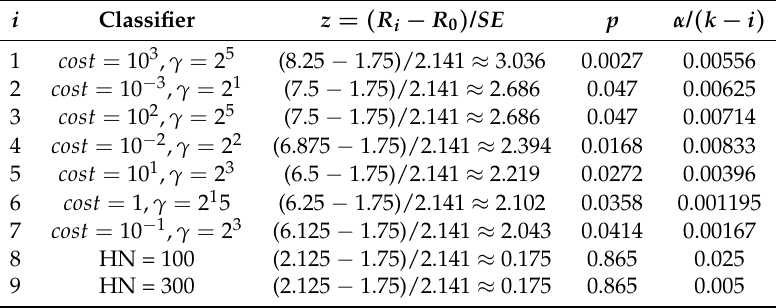
Table 16. Holm test of the testing